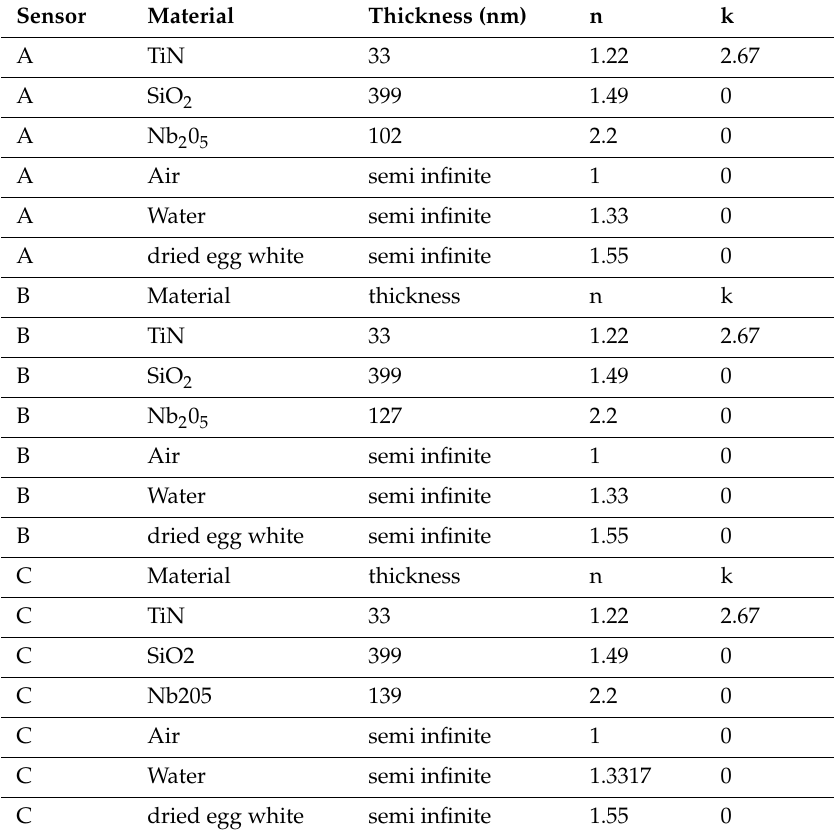
Table 2. Optical parameters, which better fix the ATR spectra of Figure